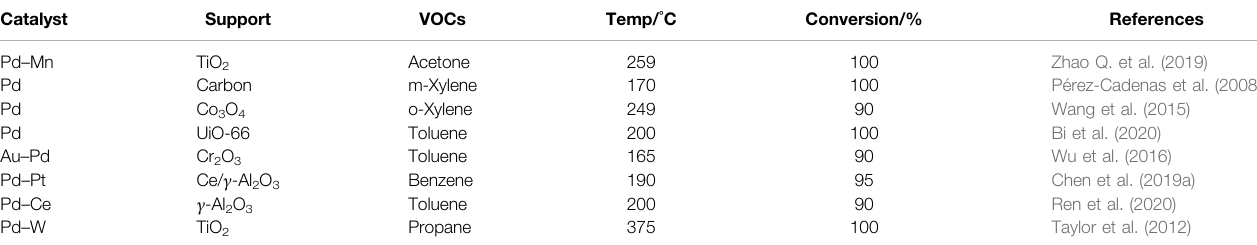
TABLE 2 | Reported Pd-supported catalysts for the oxidation of volatile organic compounds